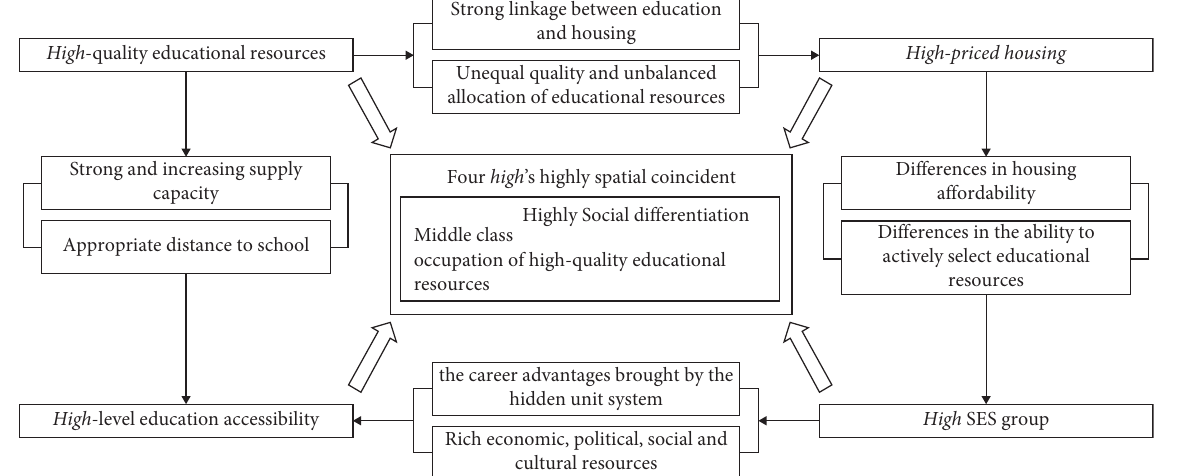
Figure 6: Social spatial differentiation and the mechanism of educational resource